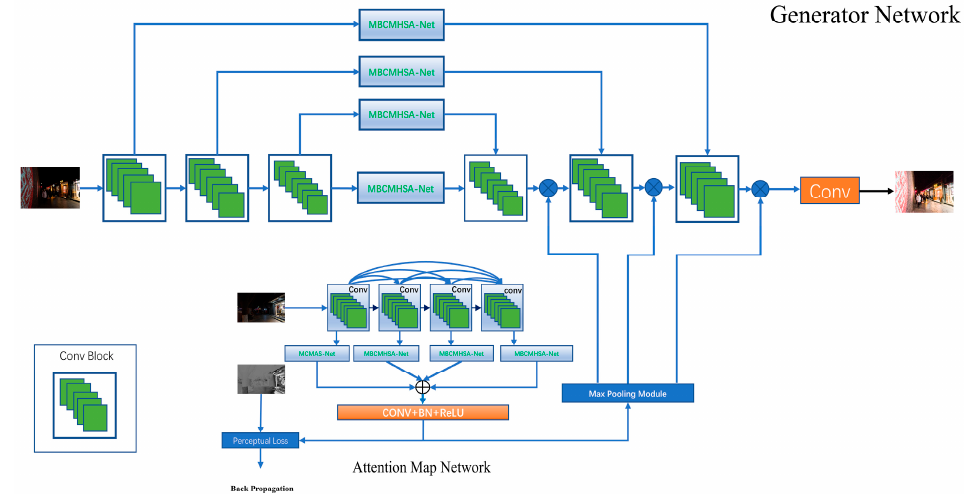
Figure 2. Network Structure of the Generator.